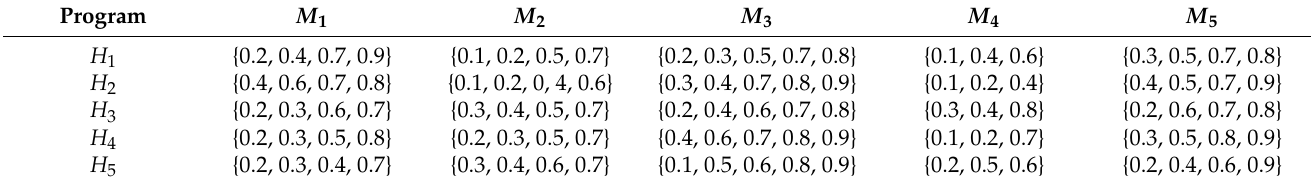
(cid:16) (cid:17) h ij for new energy vehicle 5 × 5